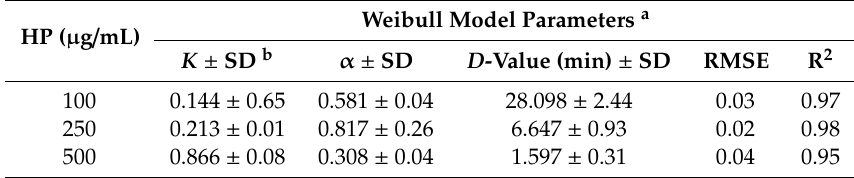
Table 5. The E ff ect of HP with di ff erent concentrations on the D -values of MNV-1. HP ( µ g / Table 5. The Effect of HP with different concentrations on the D- values of MNV-1. HP ( μ g/mL)